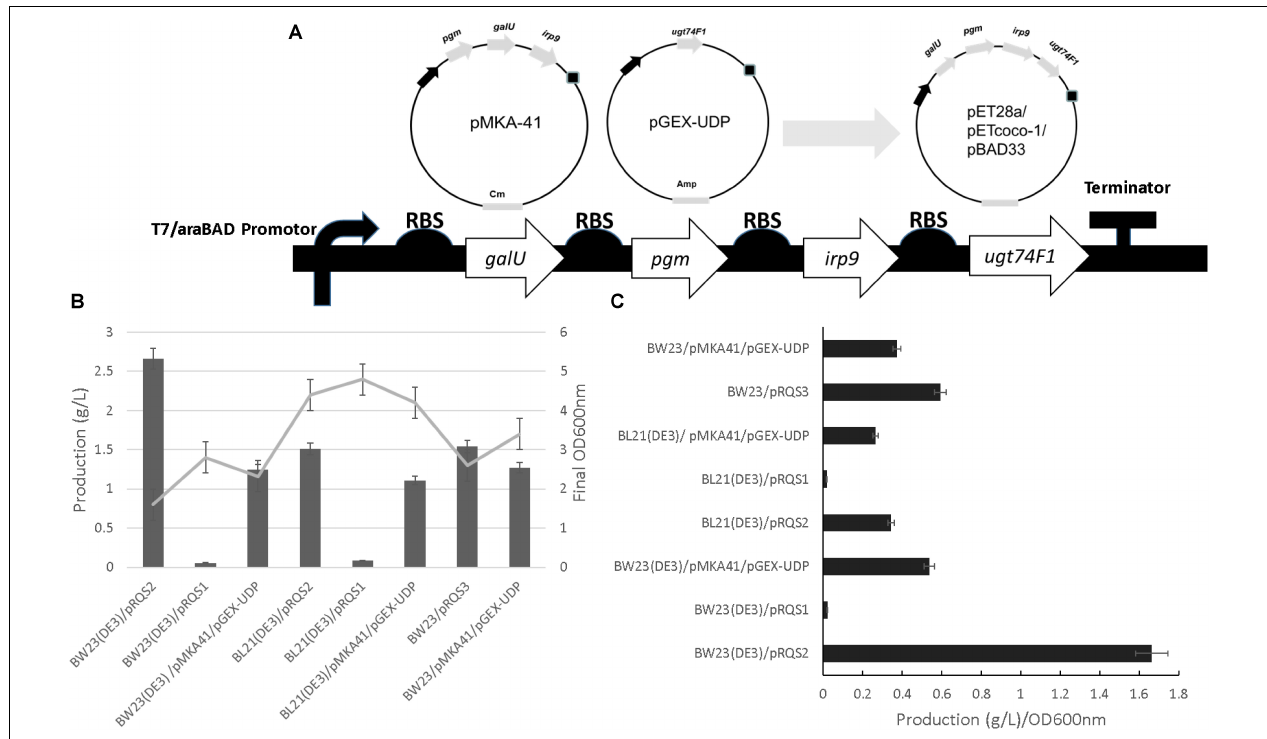
FIGURE 2 | Salicylate 2-O- β -D-glucoside plasmid construction and heterologous production. (A) The integration of irp9 , galU , pgm , and ugt74F1 into pET28a, pETcoco-1, and pBAD33 expression plasmid backgrounds, yielding pRSQ1, 2, and 3, respectively. Final OD 600 nm and production levels (B) and normalized production per cellular density (C) for SAG heterologous production